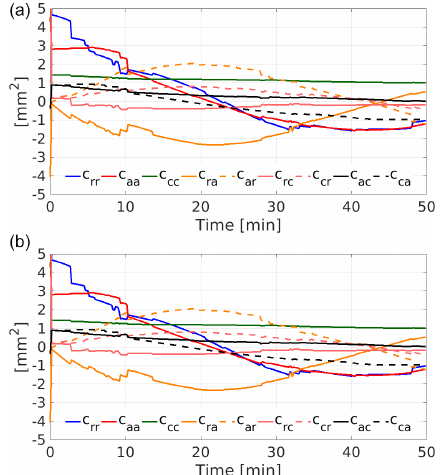
Figure 4. Covariance function over 50min for kinematic positions of GRACE-A (first 50min of day 091, 2007) in Earth-fixed refer- ence frame (a) and in LOF (b)